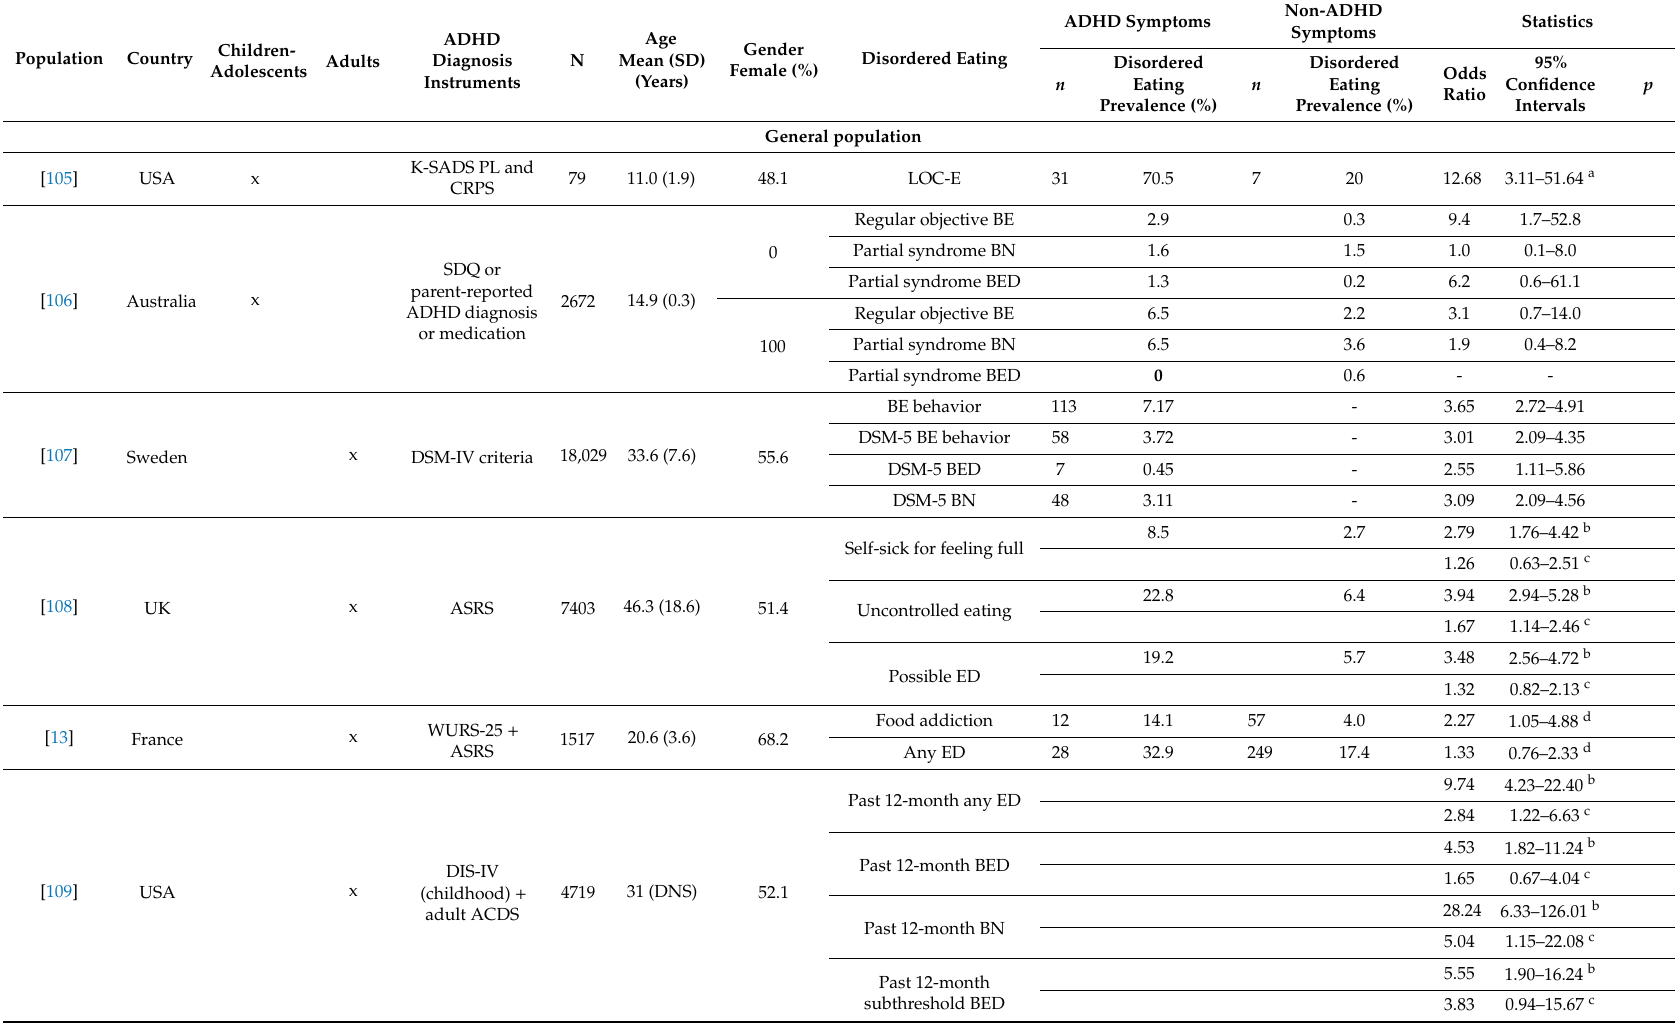
Table 2. Disordered eating prevalence among individuals with Attention-Deficit Hyperactivity Disorder